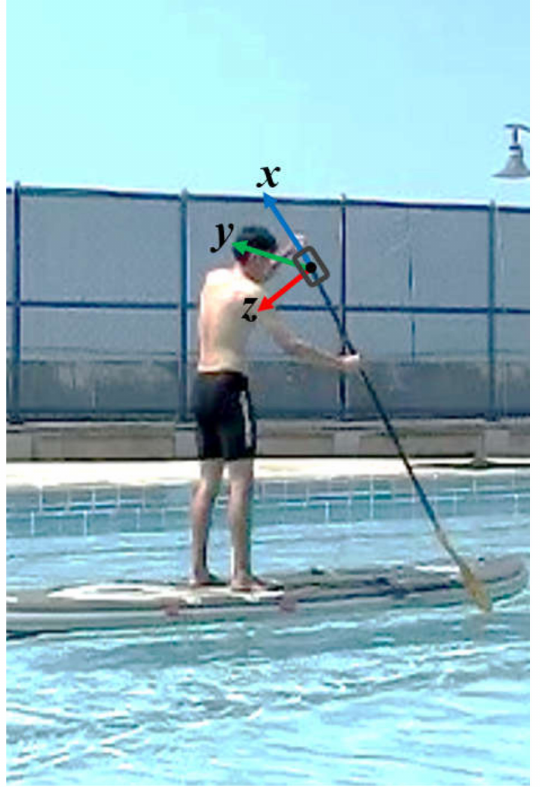
Figure 1. Accelerometer sensor placement and axis